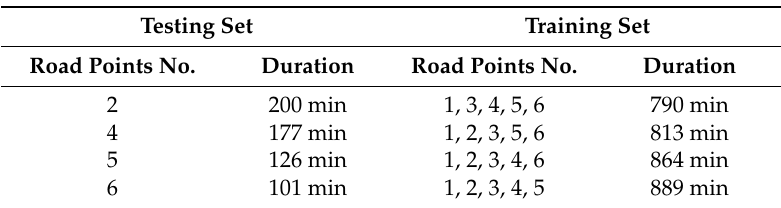
Table 2. Training and testing sets.